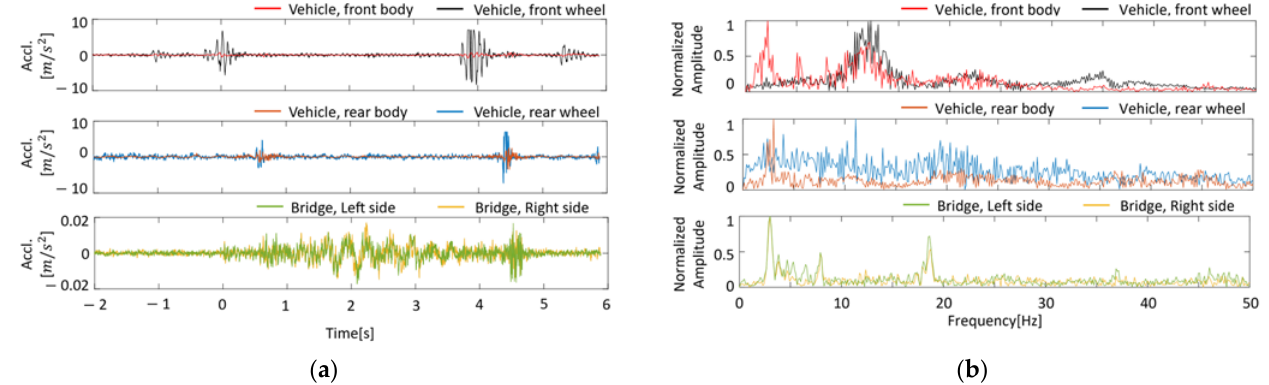
Figure 8. Vibration response of vehicle and bridge: ( a ) in time domain; ( b ) in frequency domain.